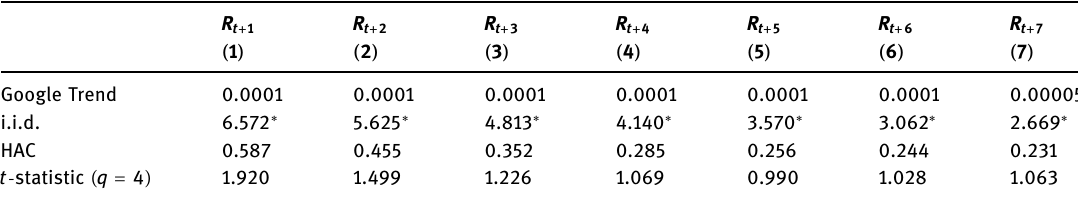
Table 6: Bitcoin and Google trend